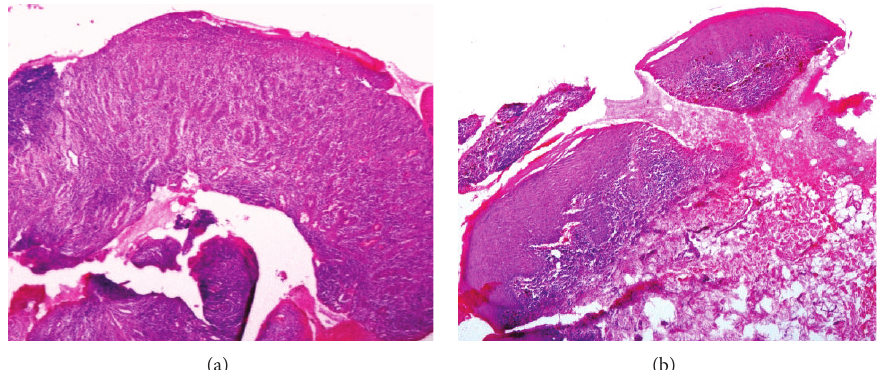
Figure 3: (a) shows localized band-like inflammatory cell infiltrate in the connective tissue and ulcerated surface epithelium with thin endothelium-lined capillary structures and inflammatory cells. (b) shows thickening of surface epithelium with basal cells vacuolization, dense lymphocytic infiltrate at epithelium connective tissue junction with serrated rete ridge